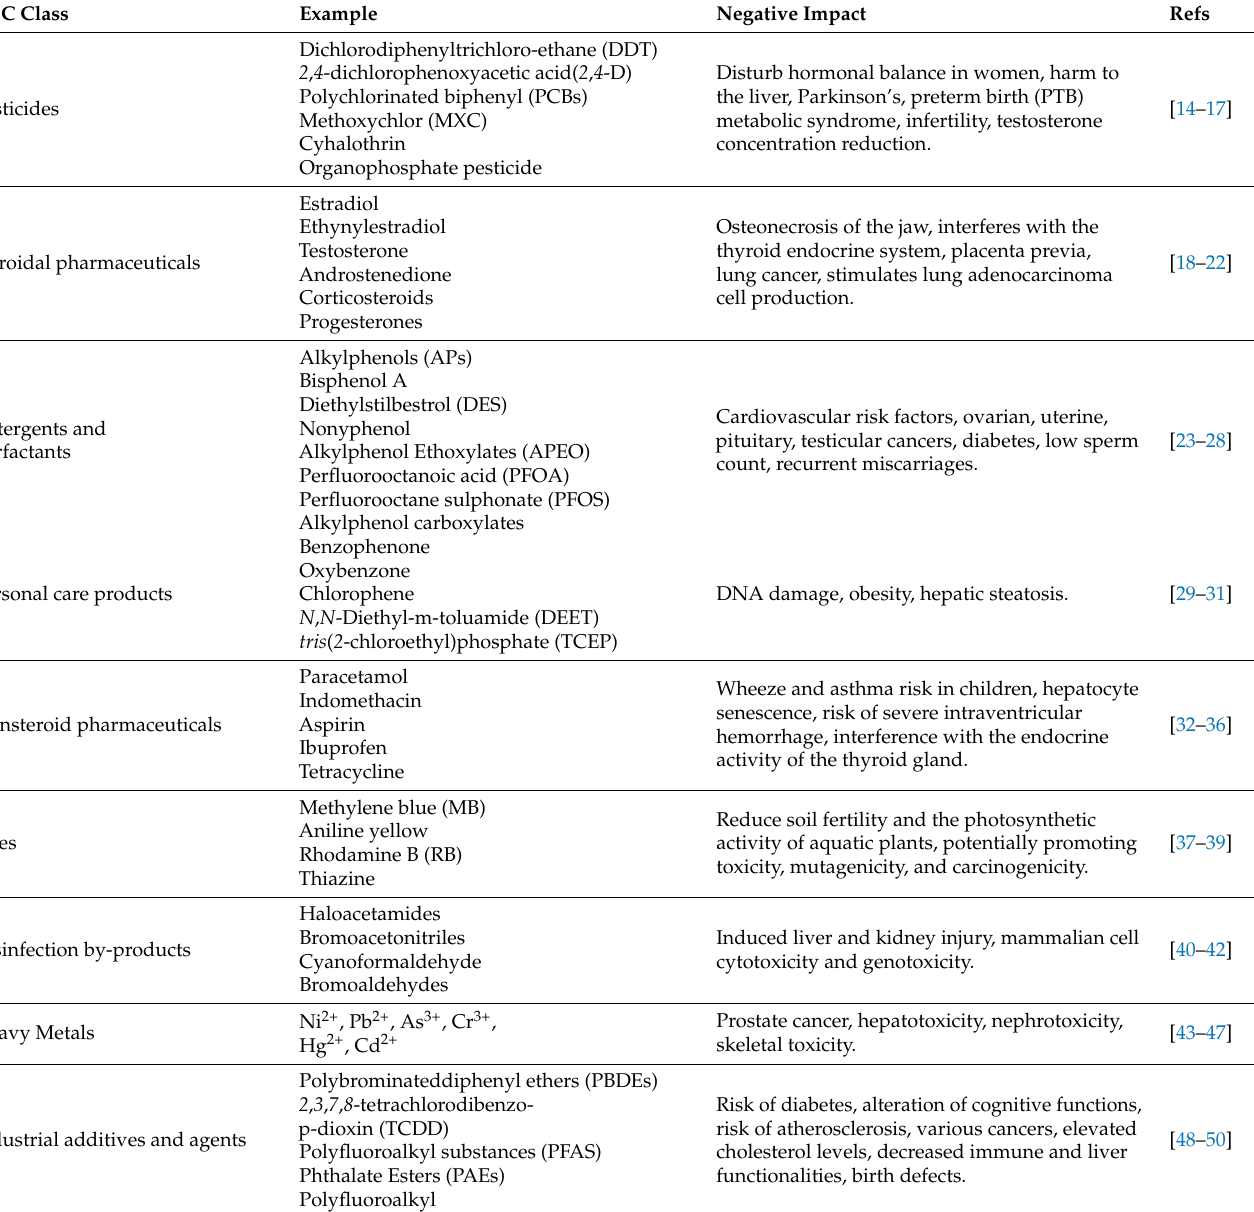
Table 1. Examples of synthetic EDCs and their negative